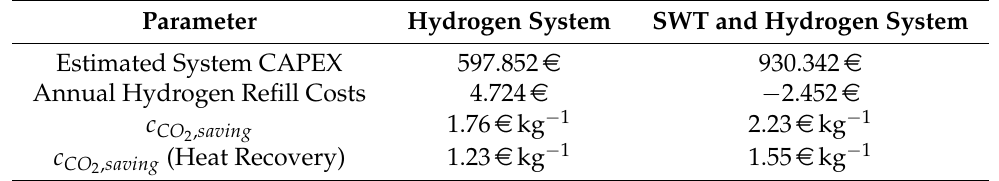
Table 17. Economic parameter